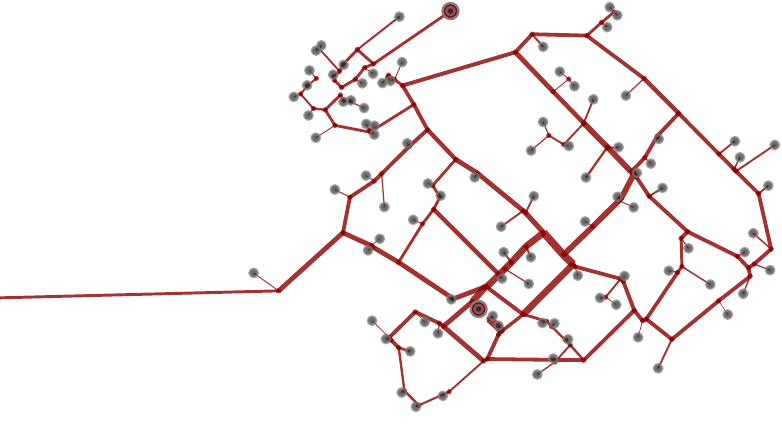
Figure A2. FZJ separation scenario 3.